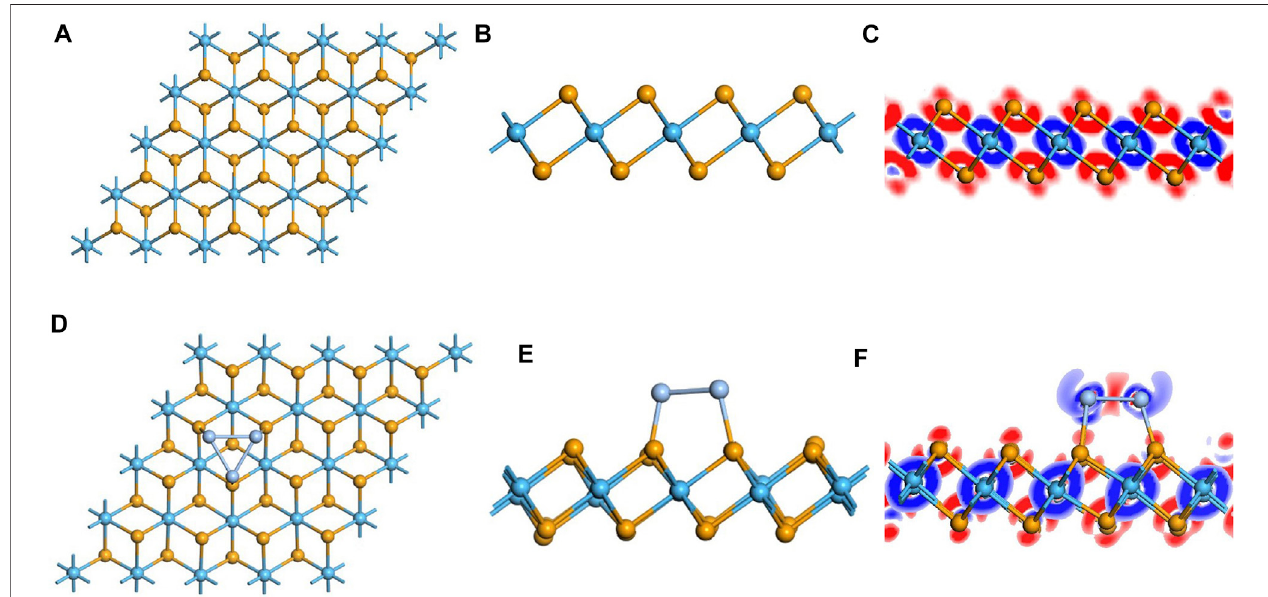
FIGURE 1 | Optimized con fi guration and electronic structures of the pristine and doped monolayer. (A – C) pristine system and (D – F) doped system. In DCD, red and blue regions represent electron accumulation and deletion.